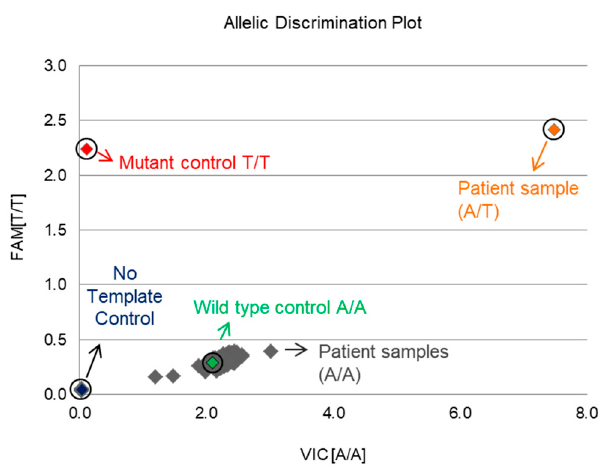
Figure 4. Screening for the GNAQ T96S (rs753716491) mutation in 456 Korean patients. A single nucleotide polymorphism (SNP) assay was performed to determine the frequency of the GNAQ T96S mutation in Korean liver cancer patients. The cancer tissues of 456 Korean liver cancer patients were collected, and DNA was extracted. DNA samples were genotyped with an rs753716491 probe in the Taqman real-time polymerase chain reaction (PCR) system.